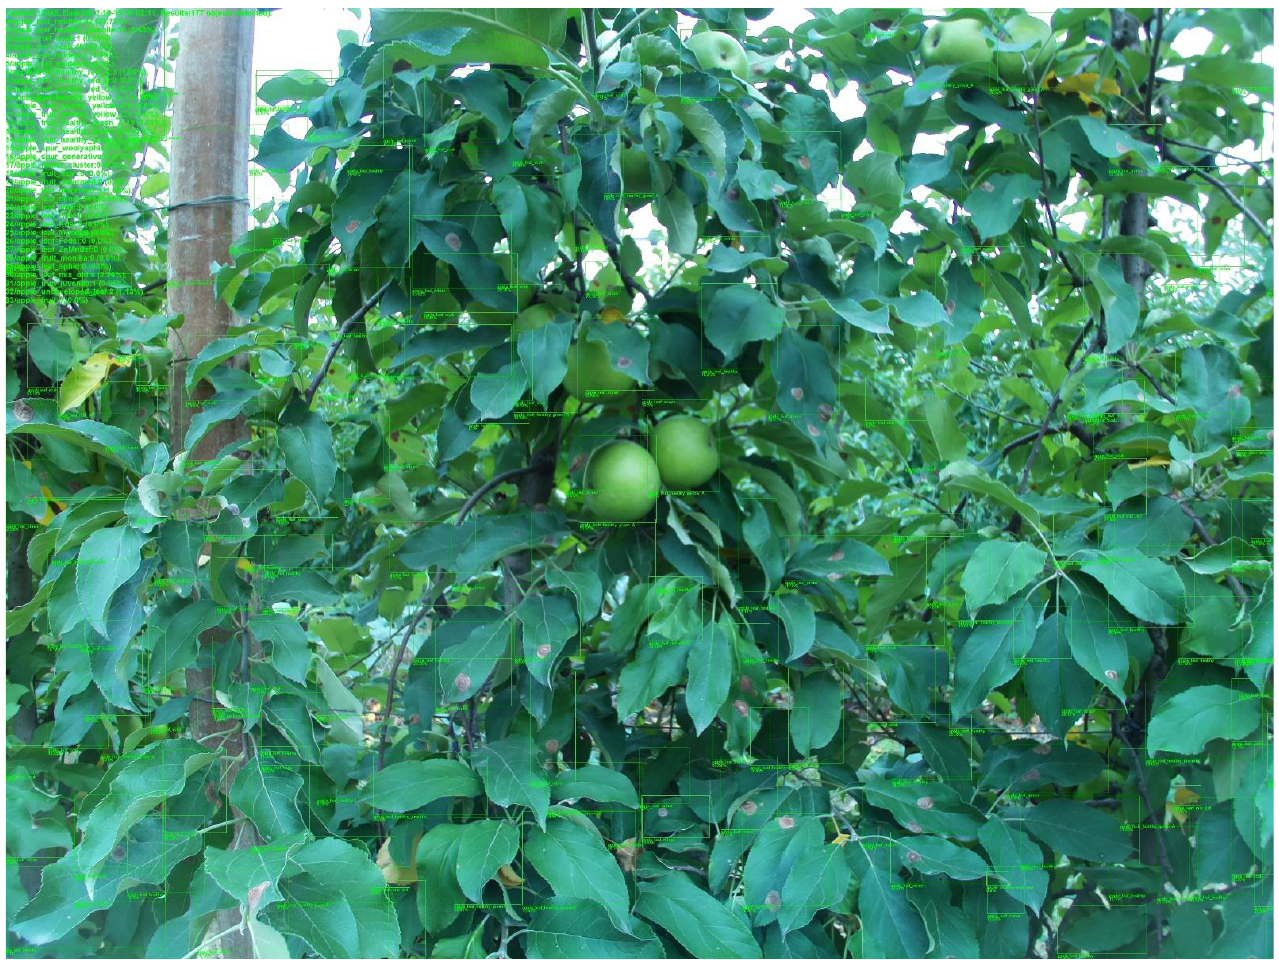
Figure 10. Example of the automatic counts of the model for the Vegetation Monitoring Device (VMD). Green bounding boxes – detected classes (MINES, OTHER).